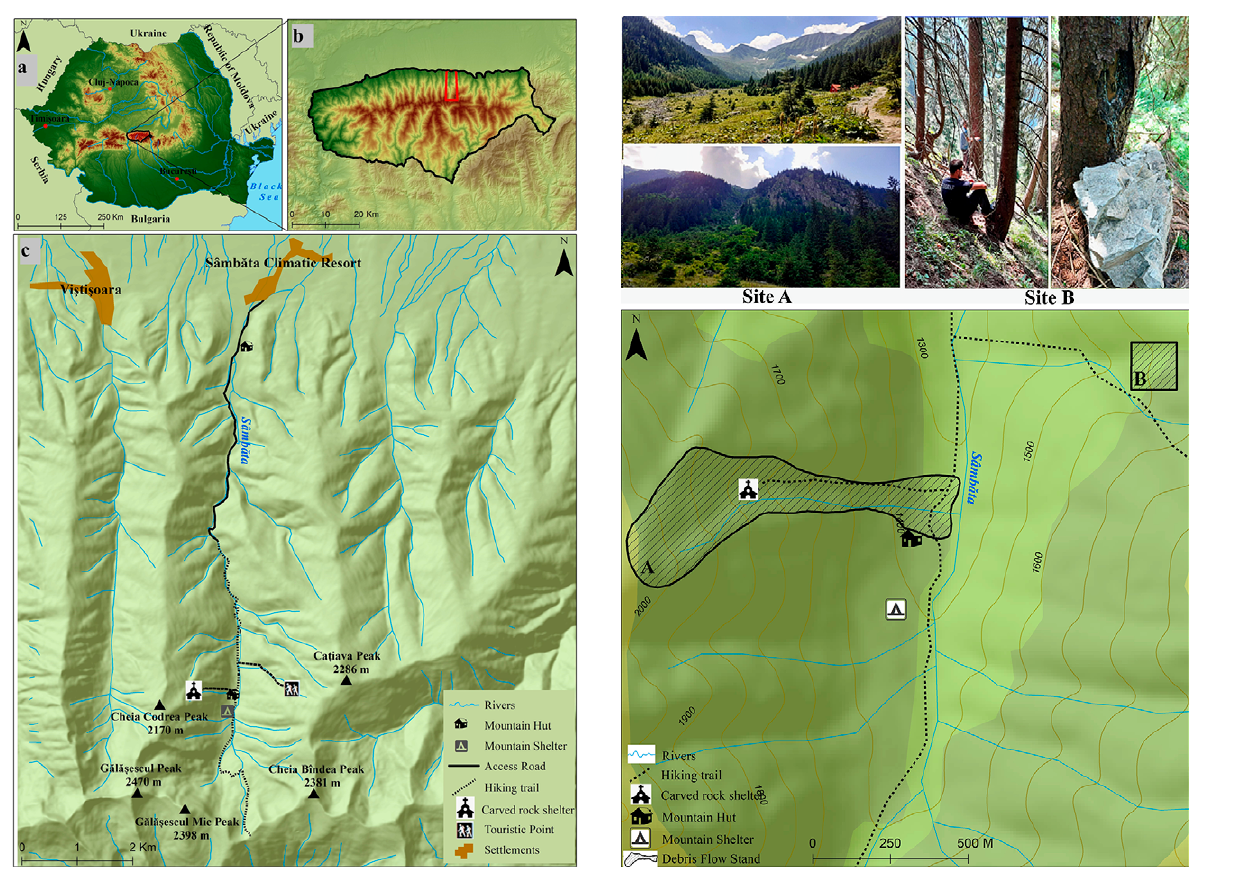
Figure 2. Location of the a. Făgăraș Mountains in Romania; b. The Sâmbăta Valley within the Făgăraș Mountains; and c. Map of Sâmbăta Valley